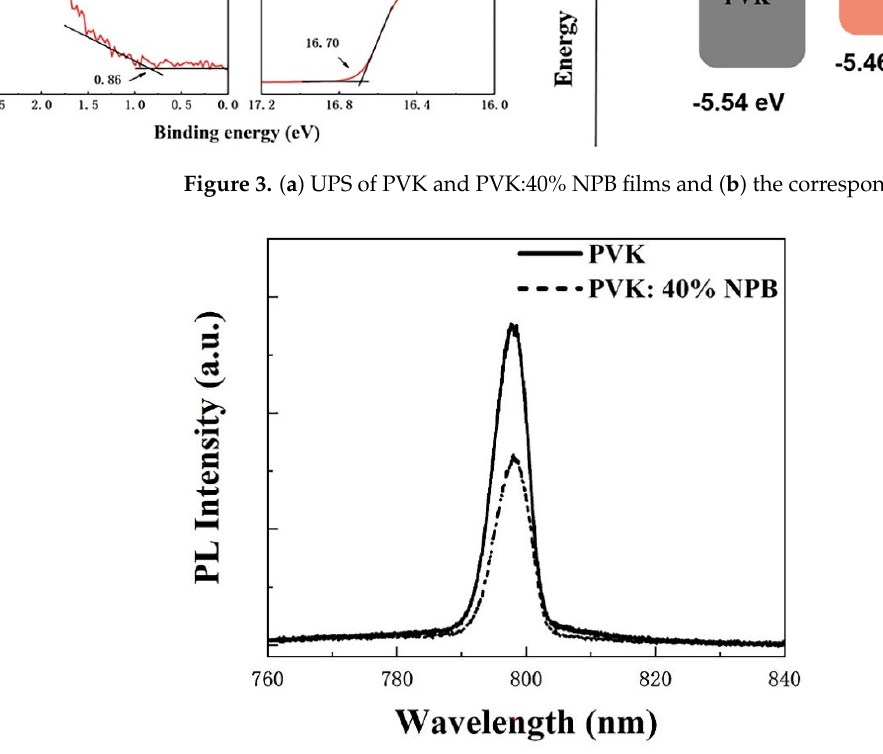
Figure 4. PL spectra of MAPbI 3 on different HTLs.